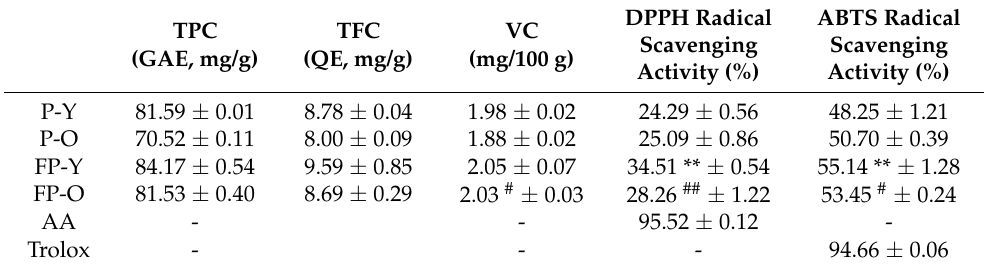
Table 1. Physicochemical content and radical scavenging